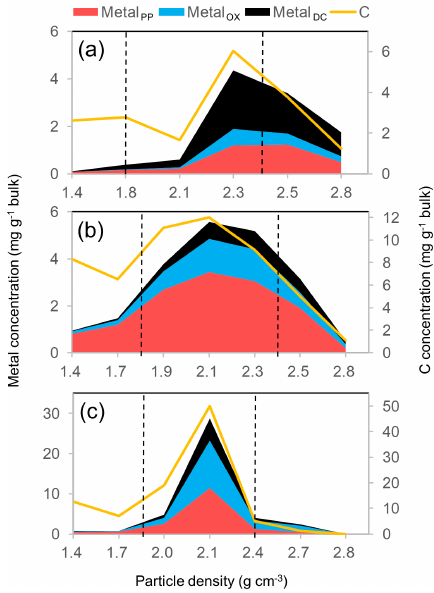
Figure 8. The distribution of the extractable metal phases (Al + 0.5Fe) on the left y axis and that of C on the right y axis along the density gradient for three undisturbed forest soils. A kaolinitic Ultisol (O-5 in Table 1) developed from sedimentary rock under tropical wet climate (a) , a Spodosol Bhs horizon (S-2) with quartz and plagioclase-rich mineralogy from glacial till under cool temper- ate moist climate (b) , and an allophanic Andisol (A-10) from tephra under warm temperate moist climate (c) . Vertical dotted lines show the meso-density